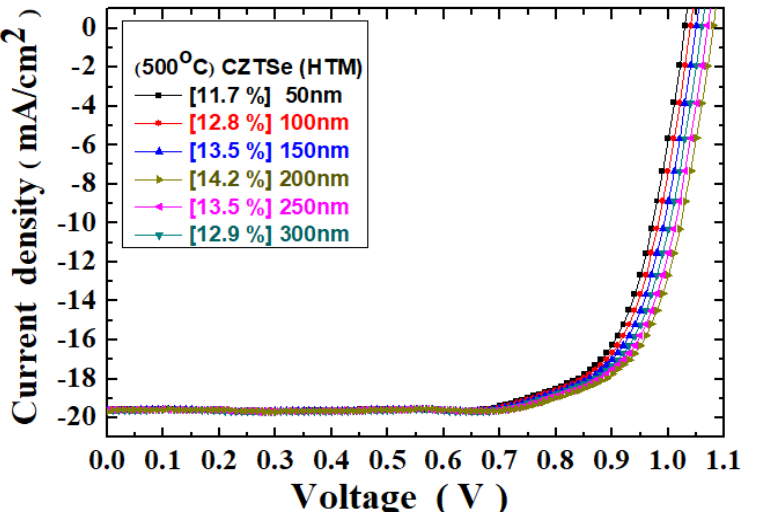
Figure 7. J–V curves for the Ag/C 60 /MAPbI 3 /CZTSe/Mo/FTO thin-film solar cells with the various